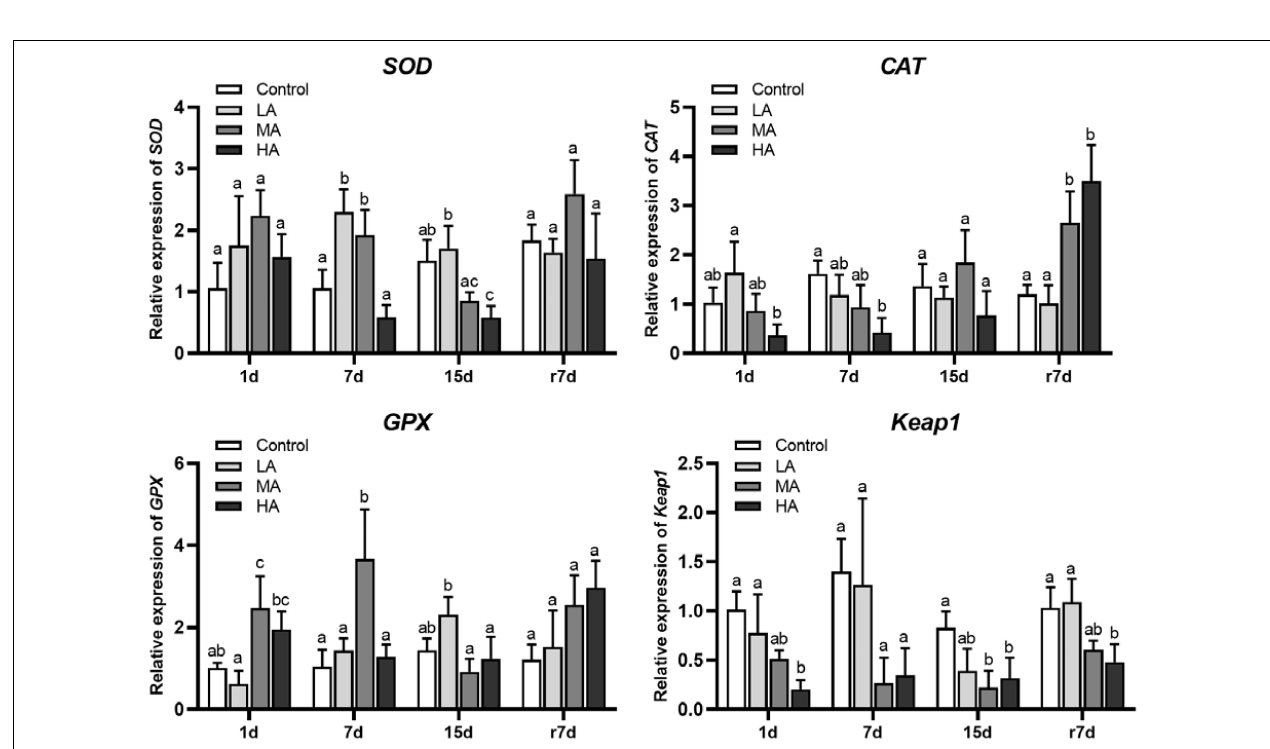
FIGURE 3 | mRNA expression of SOD , CAT , GPX , and Keap1 in hepatopancreas of P. trituberculatus after ammonia stress and recovery. Data are represented as mean ± S.D., n = 3, with P < 0.05 considered significant. Different letters represent significant differences among different groups.